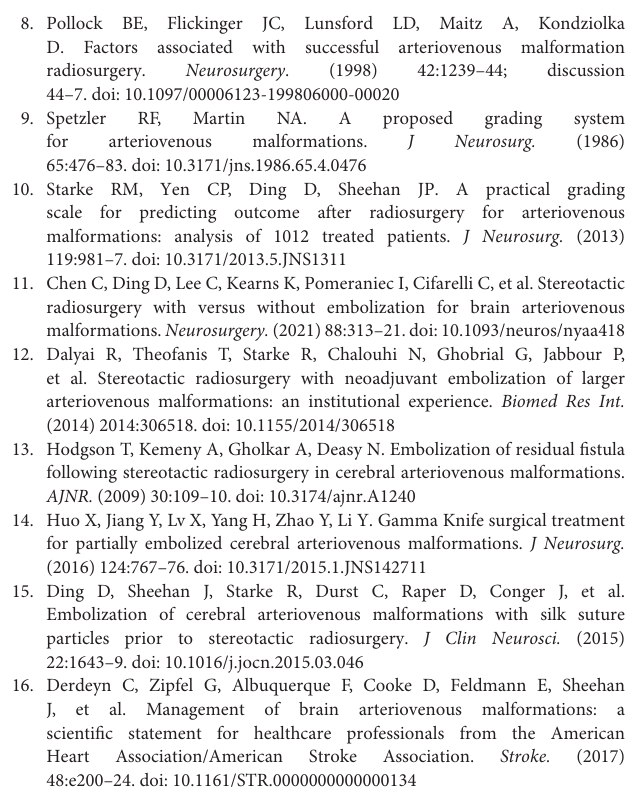
Supplementary Figure 1 | Standardized differences of baseline characteristics between brain AVM patients who received stereotactic radiosurgery with or without prior embolization before after matching. AVM, arteriovenous malformation; VRAS, Virginia Radiosurgery AVM Scale; mRBAS, modified radiosurgery-based AVM score; Dashed vertical lines indicate standardized differences of 0.2. Supplementary Figure 2 | Distribution of Radiological follow-up methods between different primary outcomes. MRI, magnetic resonance imaging; DSA, digital subtraction angiography. Supplementary Table 1 | Baseline characteristics of prior hemorrhage subgroup. Supplementary Table 2 | Baseline characteristics of unruptured